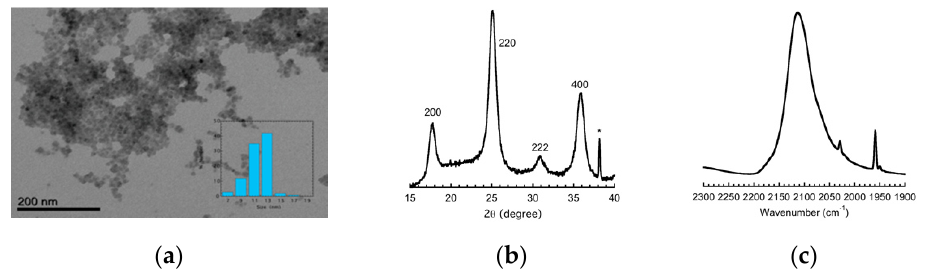
Figure 1. ( a ) Transmission Electron Microscopy imaging with count as a function of size in the inset; ( b ) Powder X-ray diffraction pattern; and ( c ) infra-red spectrum of the CsCoFe_CTA nanoparticles.